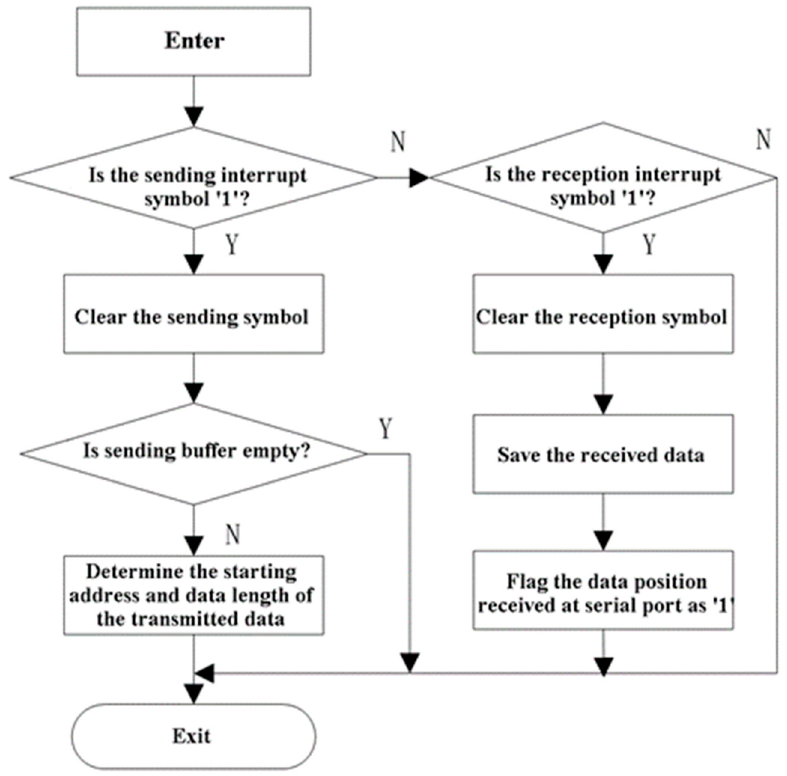
Figure 10. Flow chart of serial interrupt program.